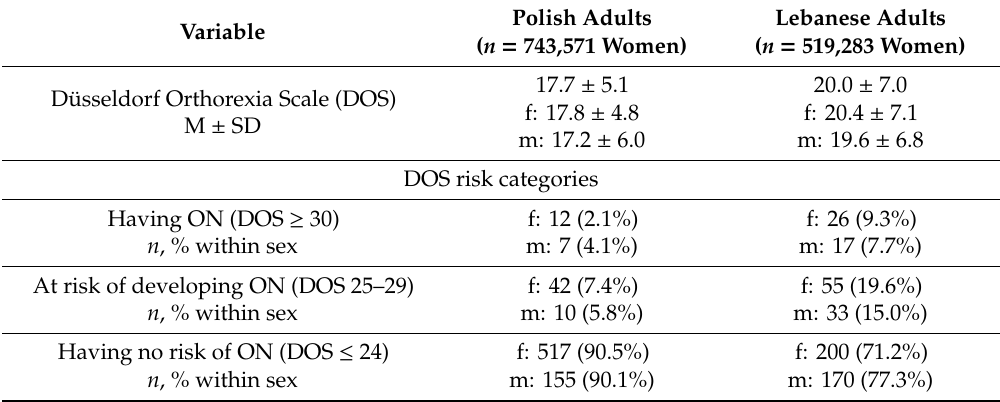
Table 4. Comparison of orthorexia nervosa (ON) prevalence among Polish and Lebanese samples. Polish Adults Lebanese Adults Variable ( n = 743,571 Women) ( n = 519,283 Women) Düsseldorf Orthorexia Scale (DOS) M ± SD DOS risk categories Having ON (DOS ≥ 30)